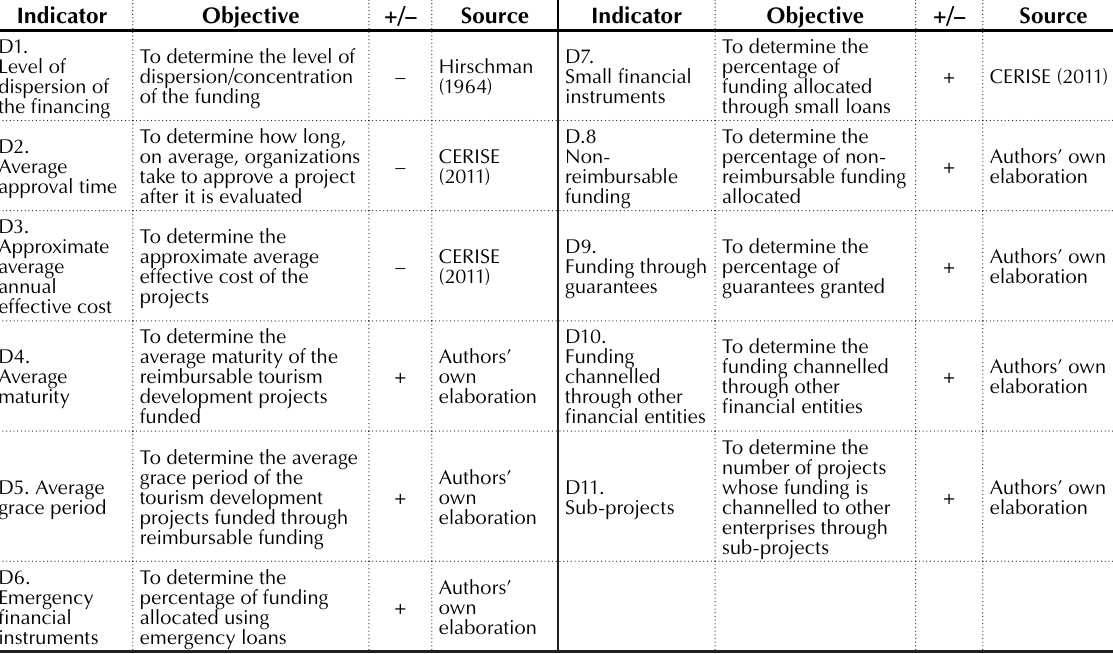
Table 5. Indicators for the study of the characteristics of the funding